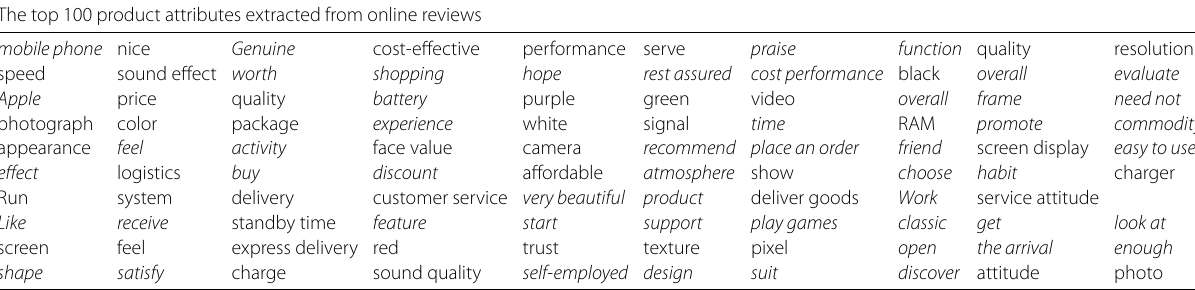
Table 2 Top 100 product attributes extracted from online reviews The top 100 product attributes extracted from online reviews mobilephone nice